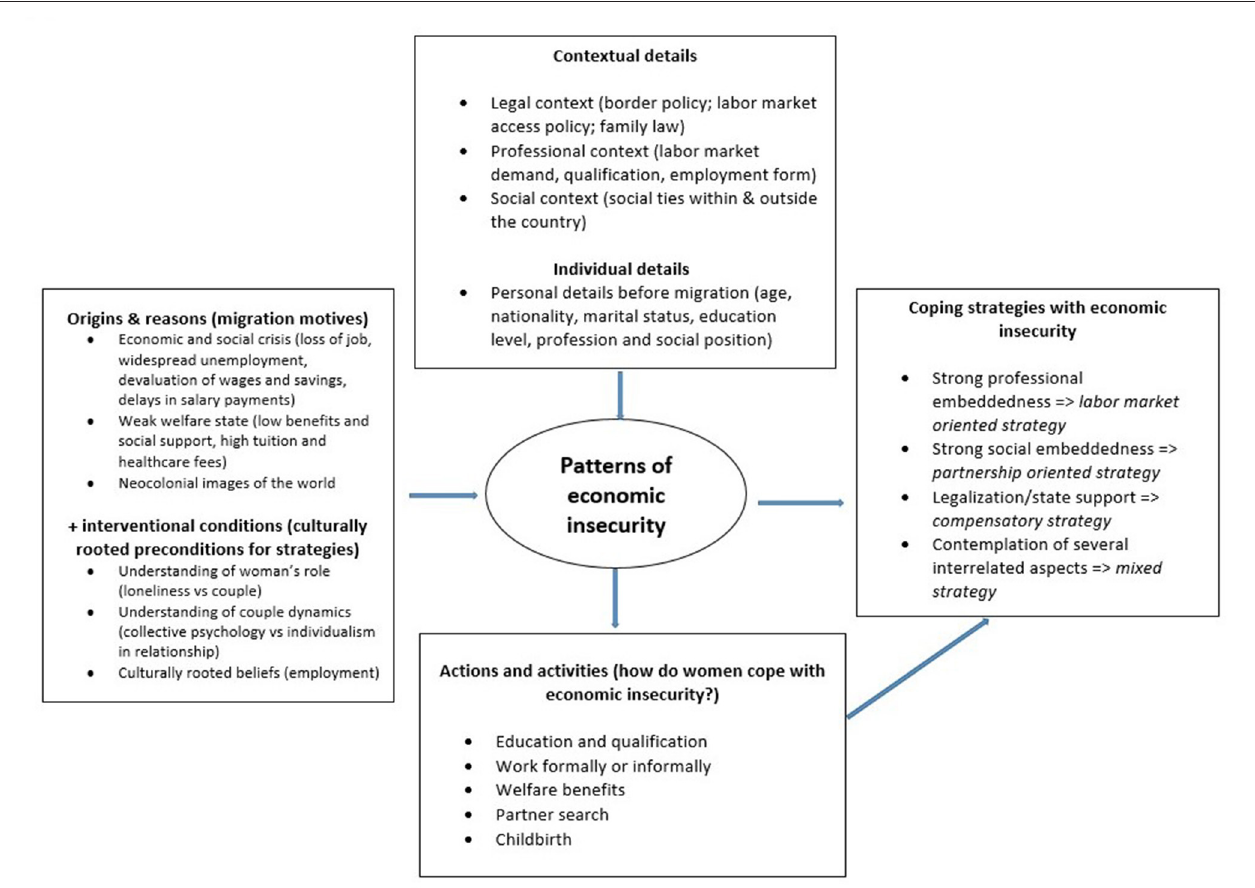
FIGURE 2 | Overview of patterns of coping with